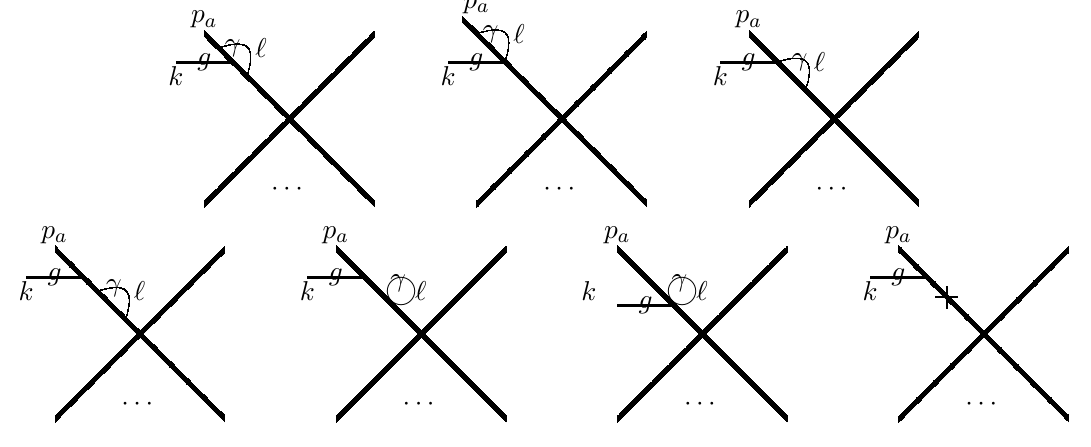
Figure 18 . One loop contribution to soft graviton amplitude involving internal photon line con- necting two points on the same